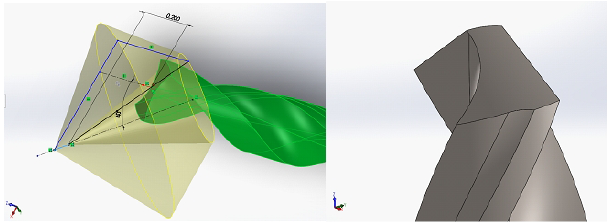
Figure 28. SolidWorks modeling of the drill bit cutting edge.